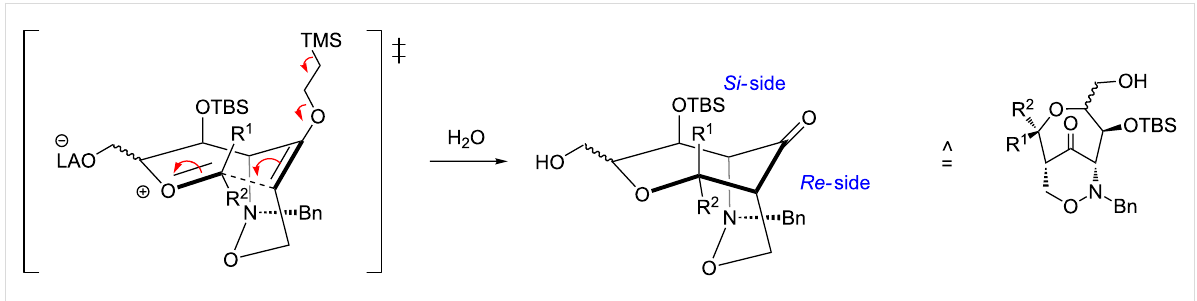
Scheme 5: Proposed extended chair-like conformation with Zimmerman–Traxler-type transition